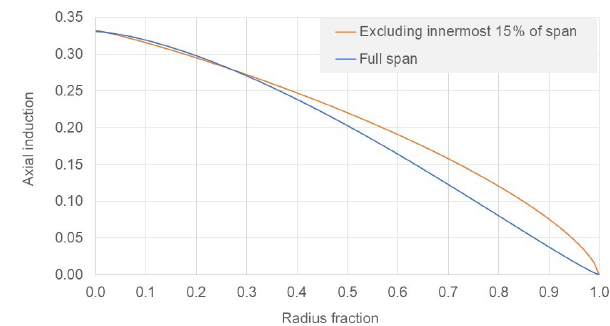
Figure 8. Axial induction distributions for maximum power gain. Table 2. Parameters of the distributions for maximum power